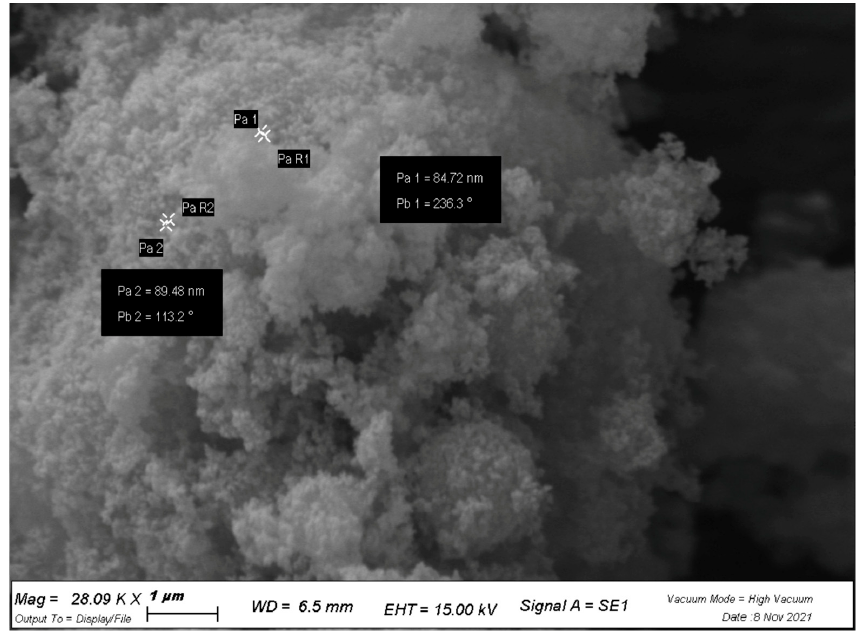
Figure 7. SEM image of nanometric Titanium Dioxide (Nano), Aluminum Hydroxide, Stearic Acid, 28,000× magnification.